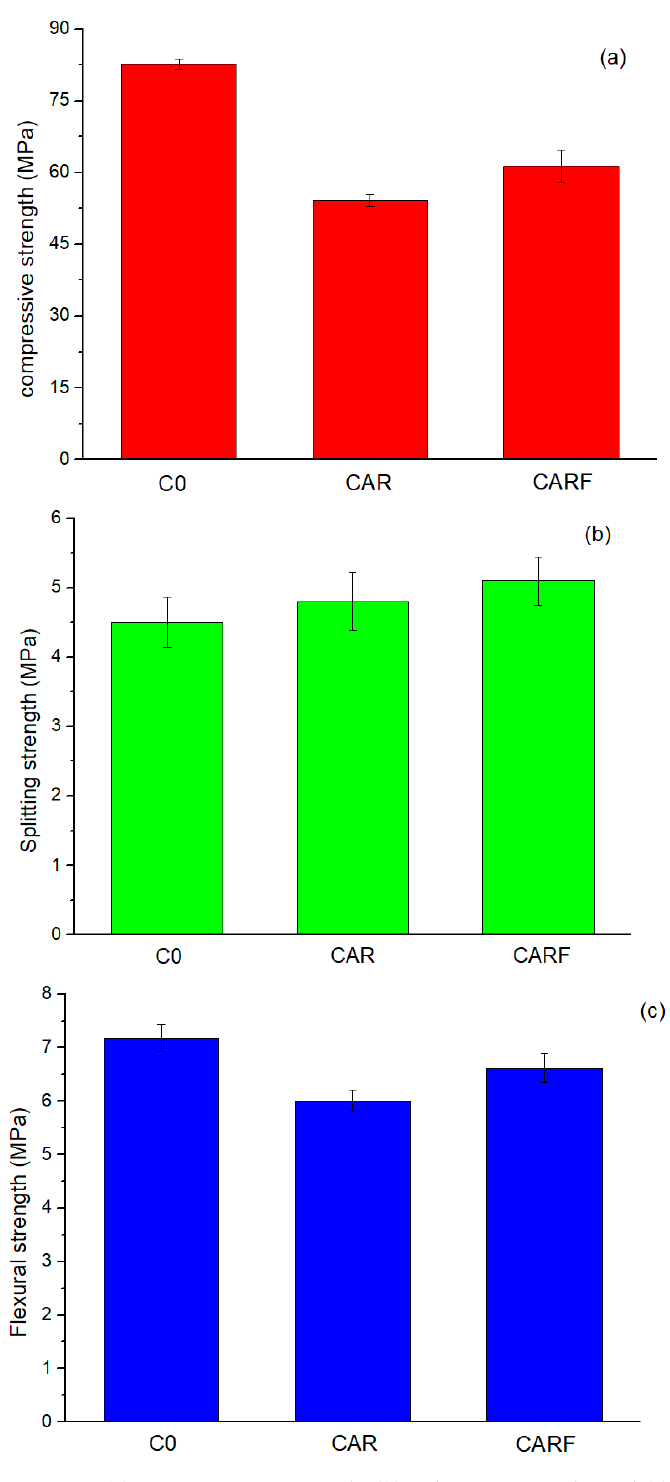
Figure 4. ( a ) Compressive strength, ( b ) splitting strength, and ( c ) flexural strength of specimens incorporating toughening